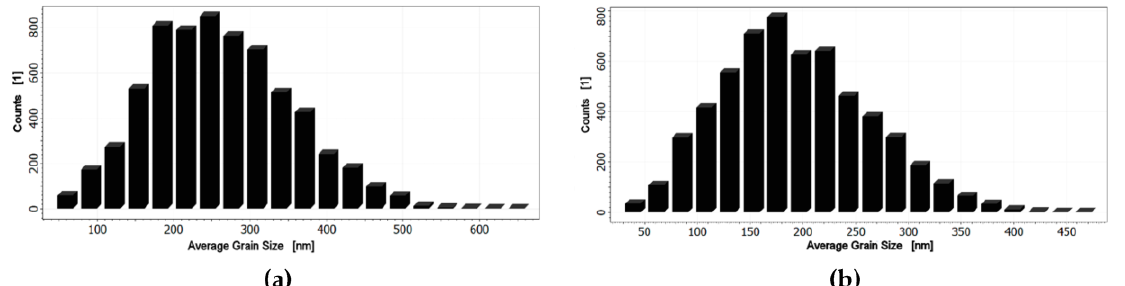
Figure 6. Histograms of the average grain size of ( a ) “upgraded” ( x = 5-4-3) and ( b ) “downgraded” ( x = 3-4-5) BST thin films deposited on the stainless-steel substrate.